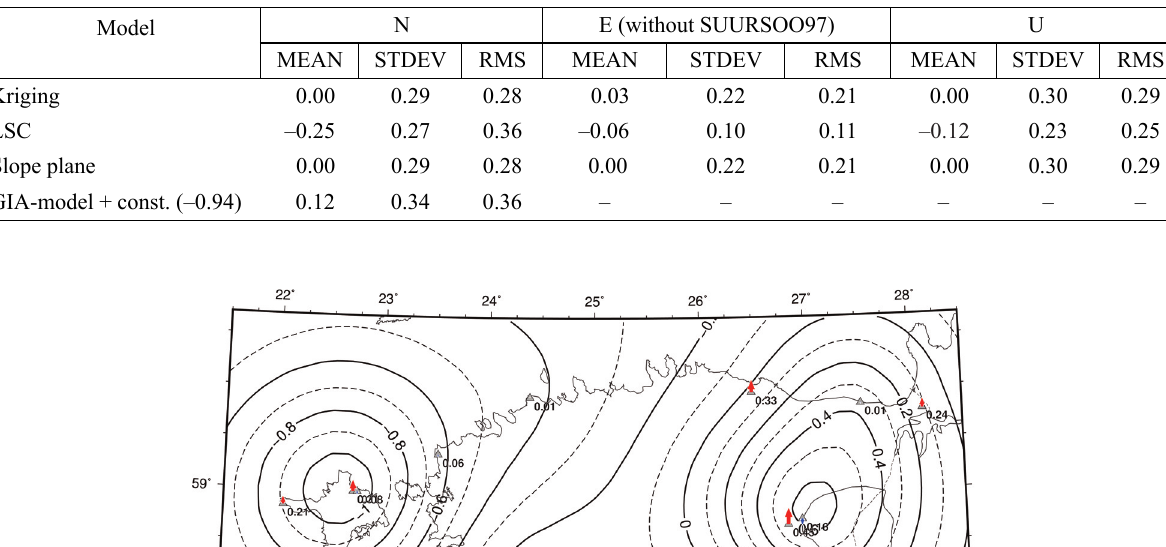
Table 7. Statistics of the differences between modelled surfaces of residual velocities and residual velocities themselves (Tables 4 and 5 in North (N), East (E) and Up (U) directions. Unit is mm/a